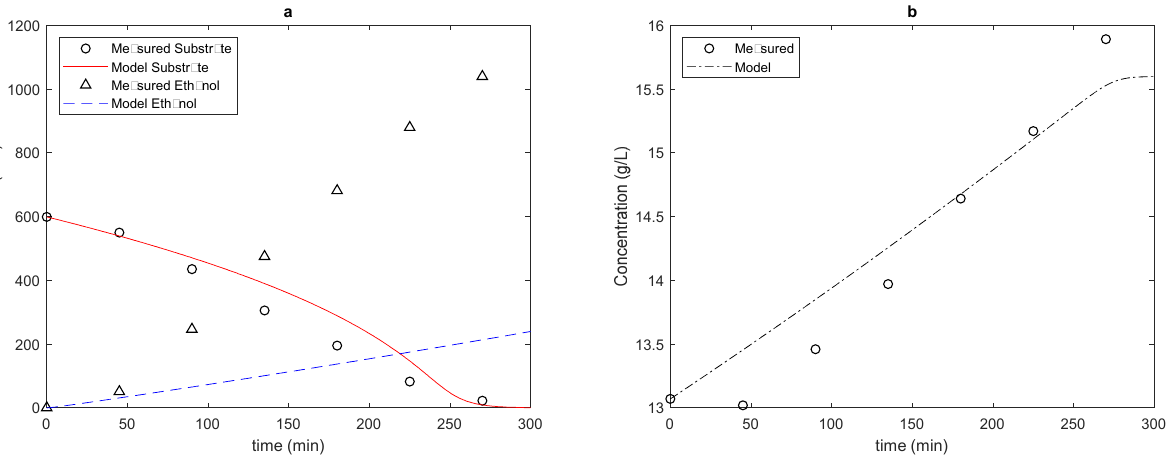
Figure 4. ( a ) SR model result with an initial concentration of 100 g/L, and ( b ) adjustment of cell